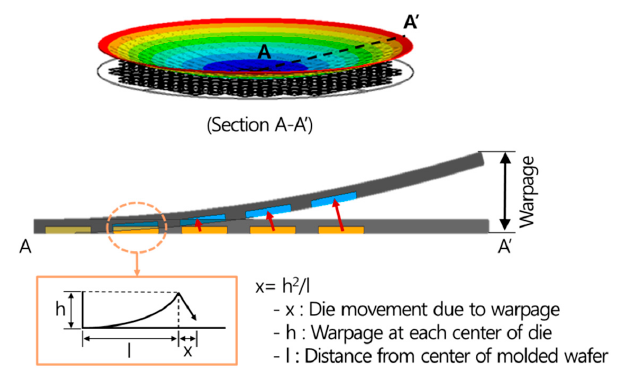
Figure 11. Evaluation of die shift caused by warpage.